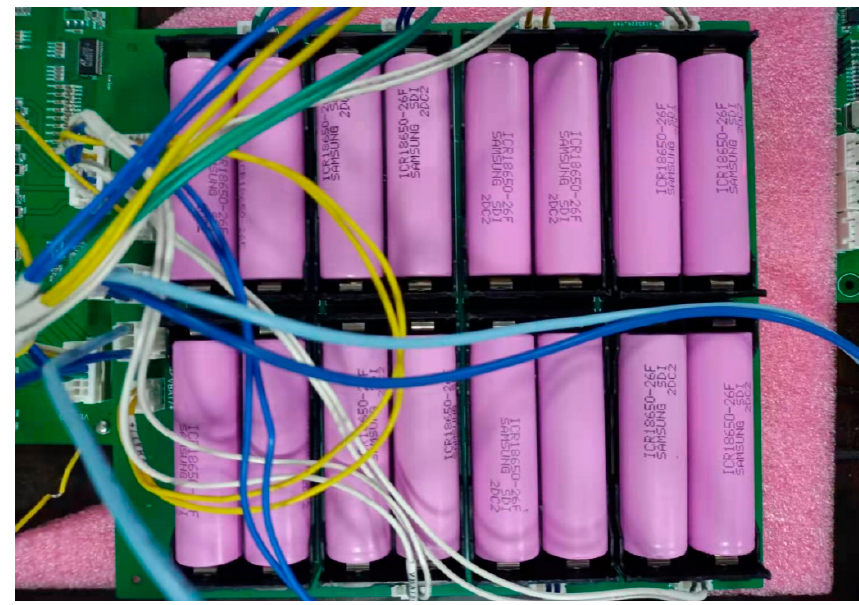
Figure 6. The schematic diagram of the battery pack. Table 1. The functional parameters of the BMS slave monitoring circuit.